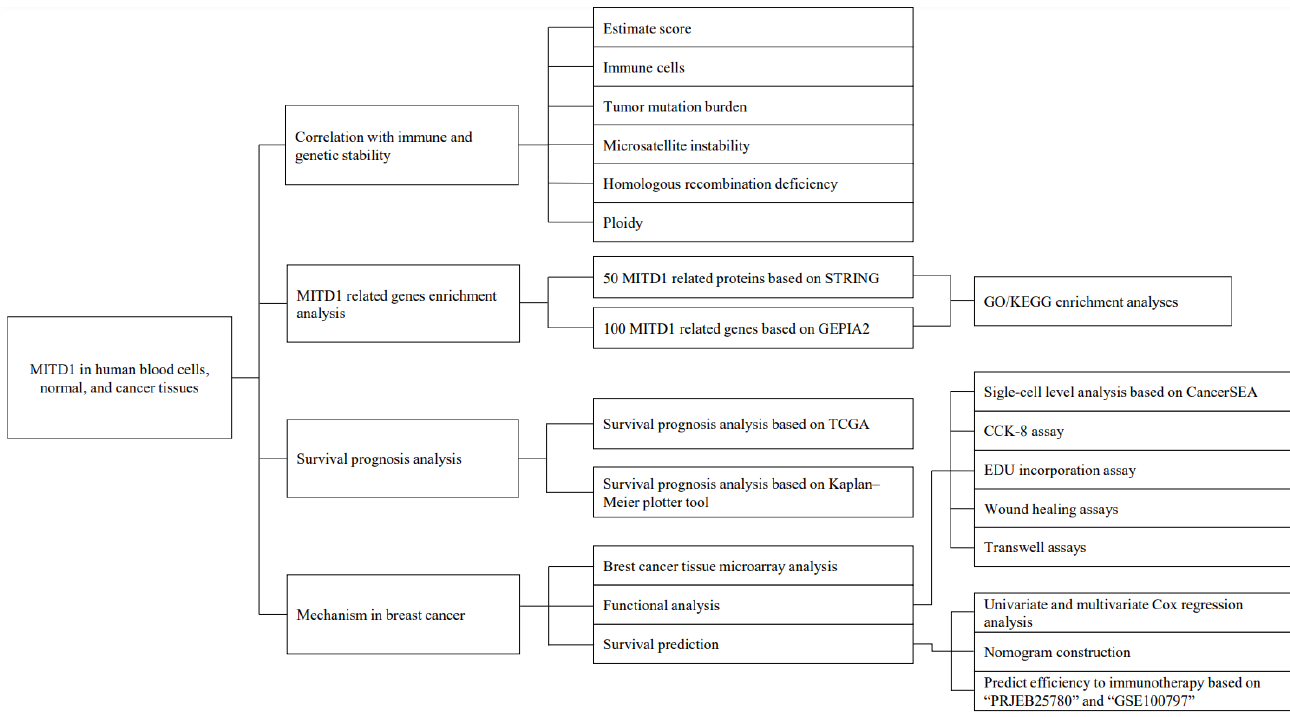
Figure 1. Summary of this study design.